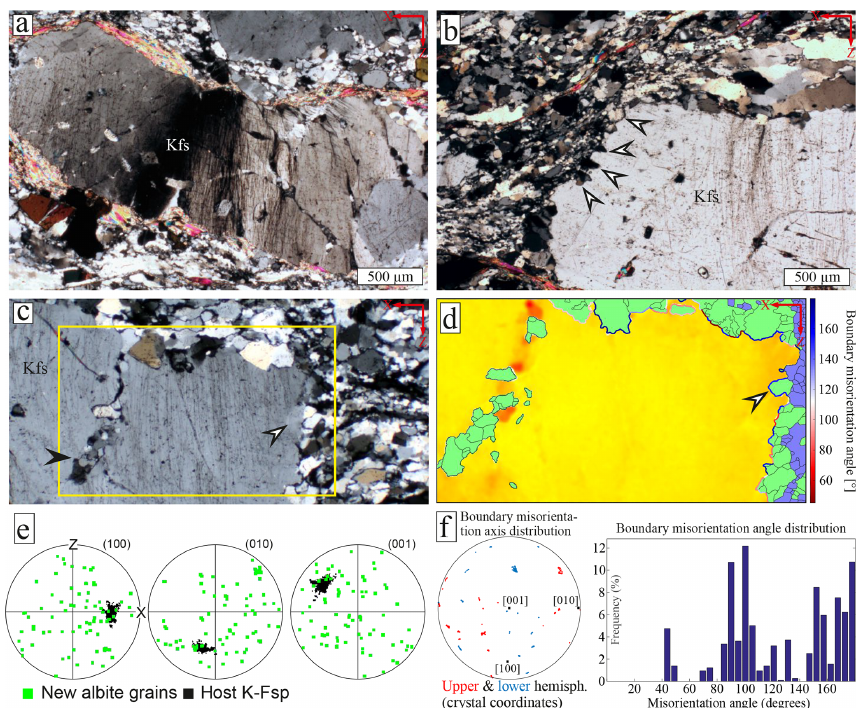
Figure 5. K-feldspar deformation microstructures (sample CT599). (a, b) Polarized light micrographs (crossed polarizers) of bent K-feldspar porphyroclast with healed microcracks at a high angle to the stretching lineation and cuspate grain boundaries (white arrows in panel b ). (c) Polarized light micrograph (crossed polarizers) showing K-feldspar with fractures filled with albite (black arrow) and cuspate phase bound- aries. Healed microcracks are cut off by newly formed albite (white arrow). The yellow rectangle shows area of EBSD map in panel (d) . (d) EBSD map, where boundaries between replacing albite grains (green) and the K-feldspar host (yellow) are coloured after their misorienta- tion angle. Quartz in the matrix is blue in colour. (e) Pole figures of poles to (100), (010) and (001) planes of new albite grains (green) and K-feldspar porphyroclast (black). (f) Misorientation angle and axis distribution for the boundaries coloured in panel (d)